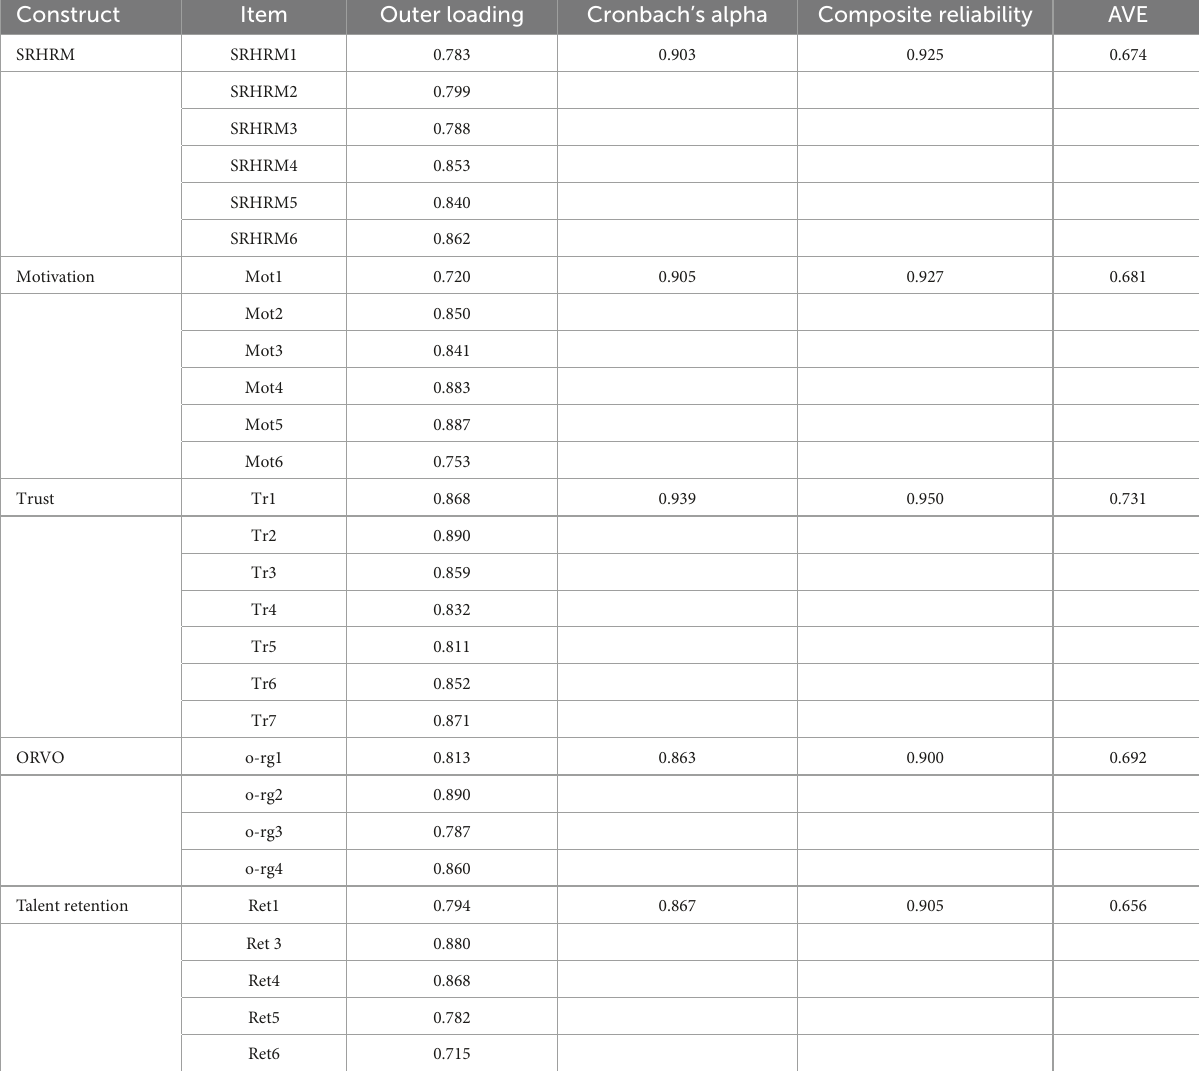
TABLE 2 Convergent